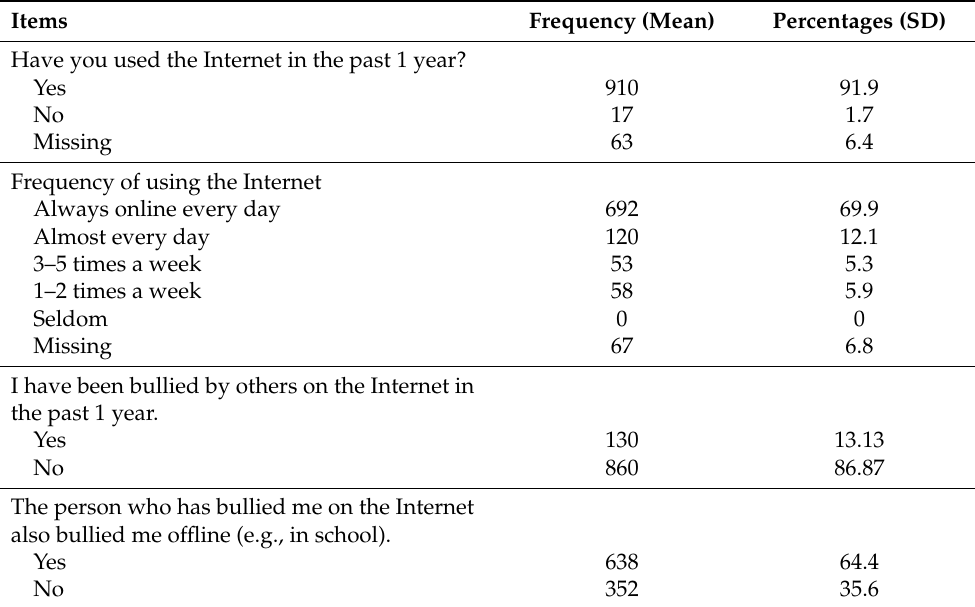
Table 1. Descriptive analysis of cyberbullying perpetration and victimization experience (n =